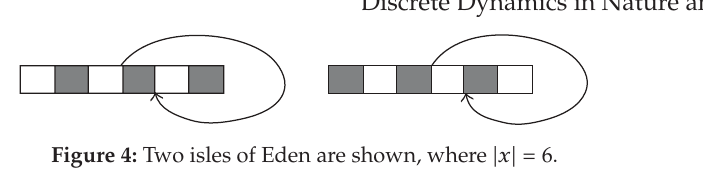
Figure 5 (cid:2) d (cid:3) , where one iteration accords with Proposition 3.5; however, the two